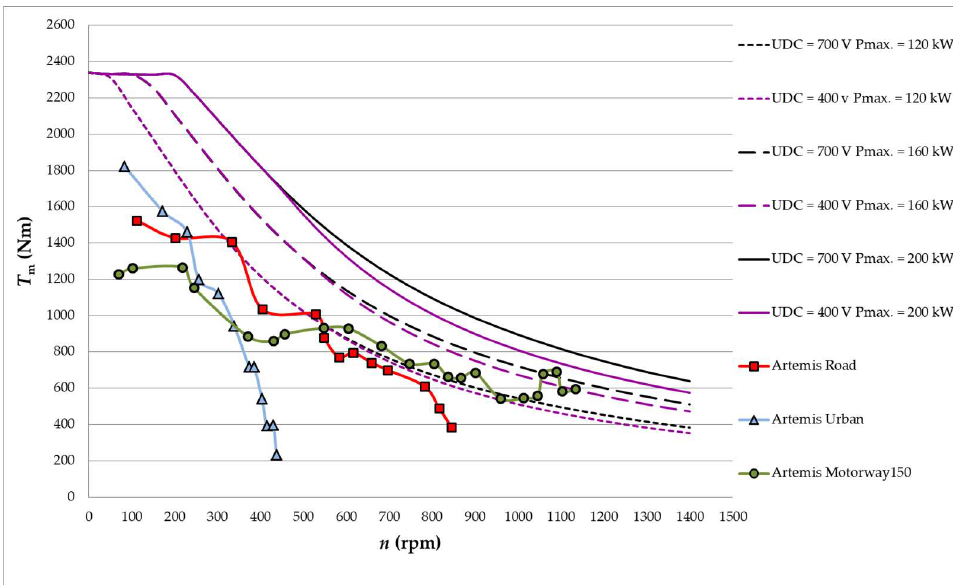
Figure 14. Maximum torque waveforms for different motor speeds in Artemis Urban, Artemis Road, and Artemis Motorway150 Cycle and plotted torque characteristics with drive input power limits for two different drive supply voltages.